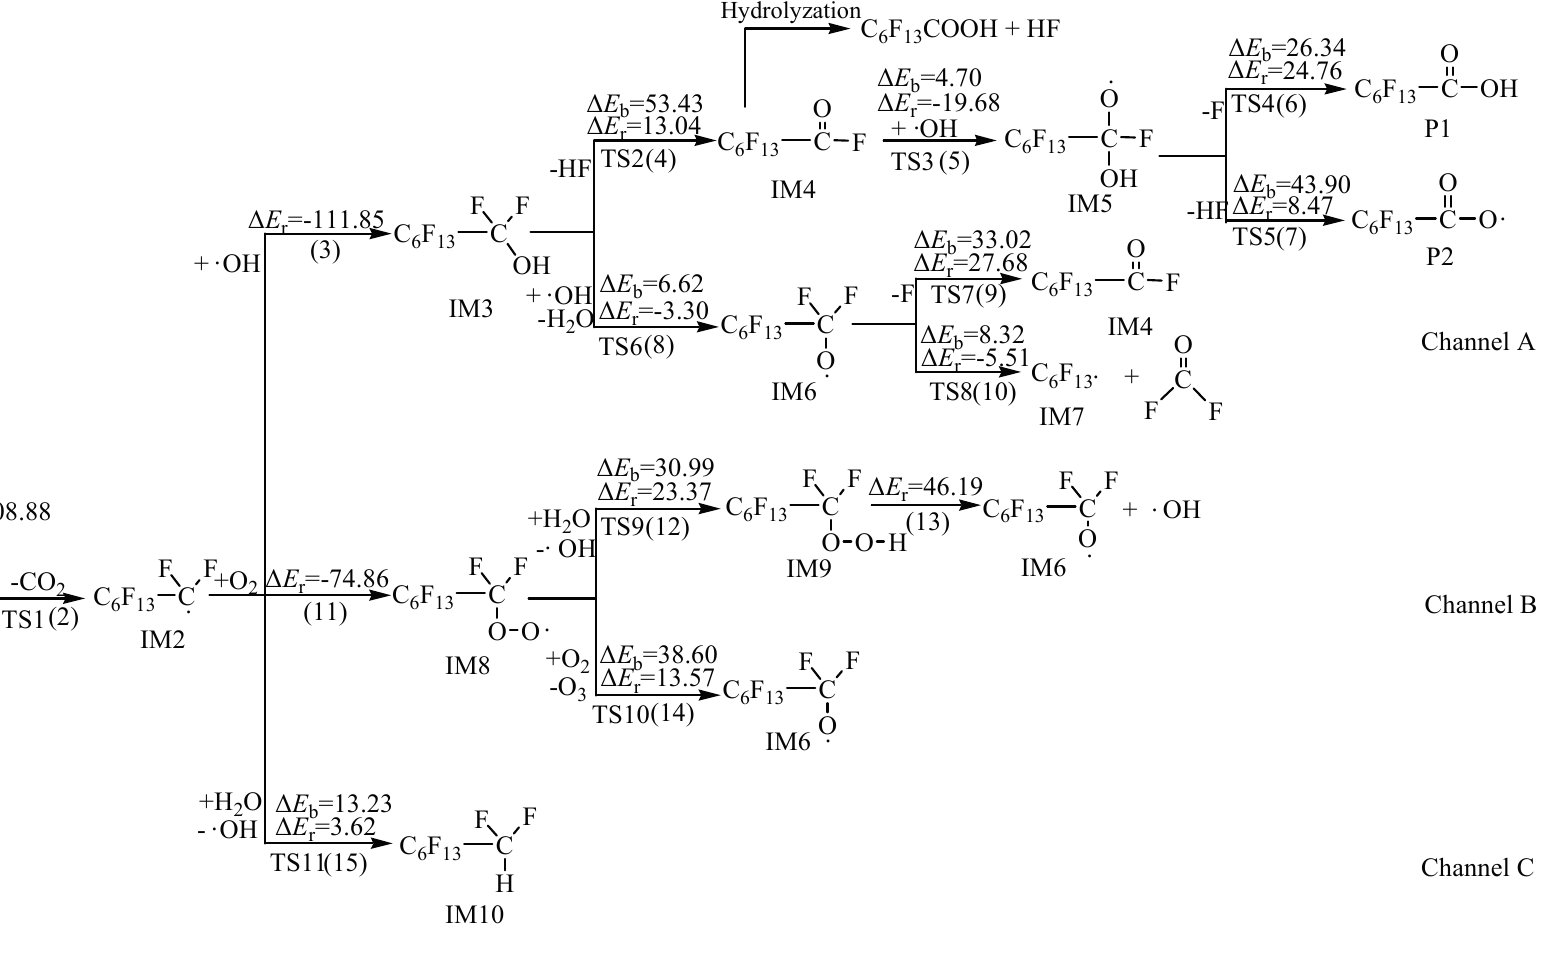
(kcal·mol − 1 ) and b